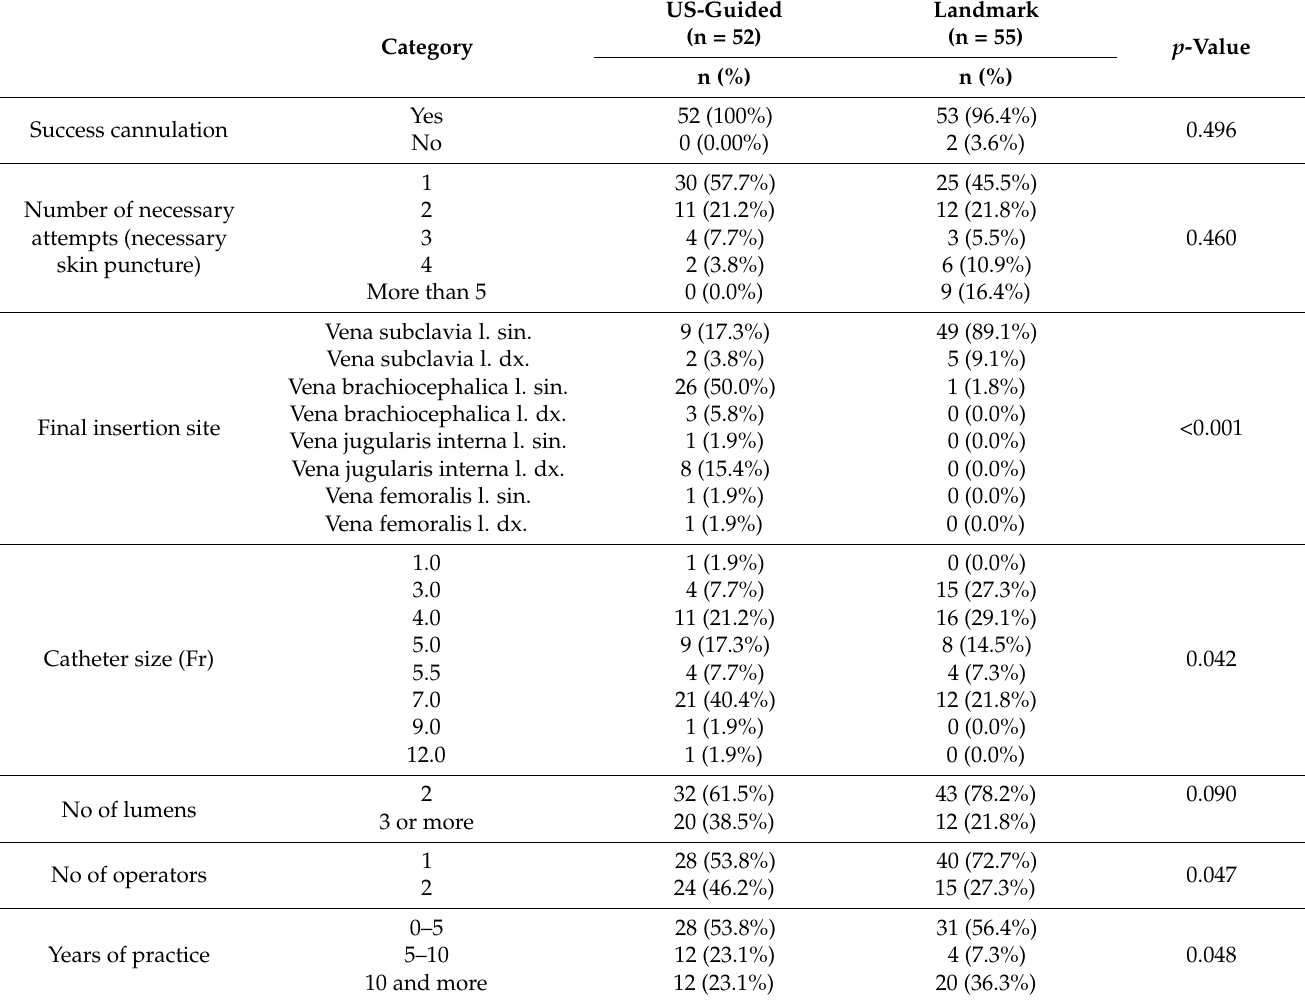
Table 3. Technical parameters of the punction.